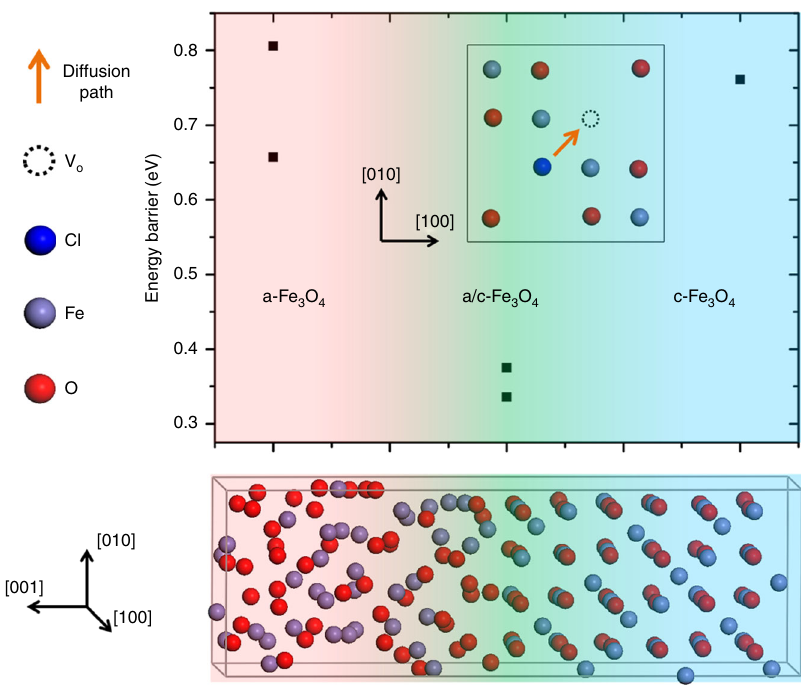
Fig. 5 Energy barriers to Cl − ion diffusion from one oxygen vacancy to a neighboring one in the three zones. Representative schematic diagram of the diffusion paths in c-Fe 3 O 4 is inserted. The diffusion barrier is lowest at the interface region, thus con fi rming that the interface between the nanocrystals and the amorphous zone provides a favorable channel for chloride ion diffusion